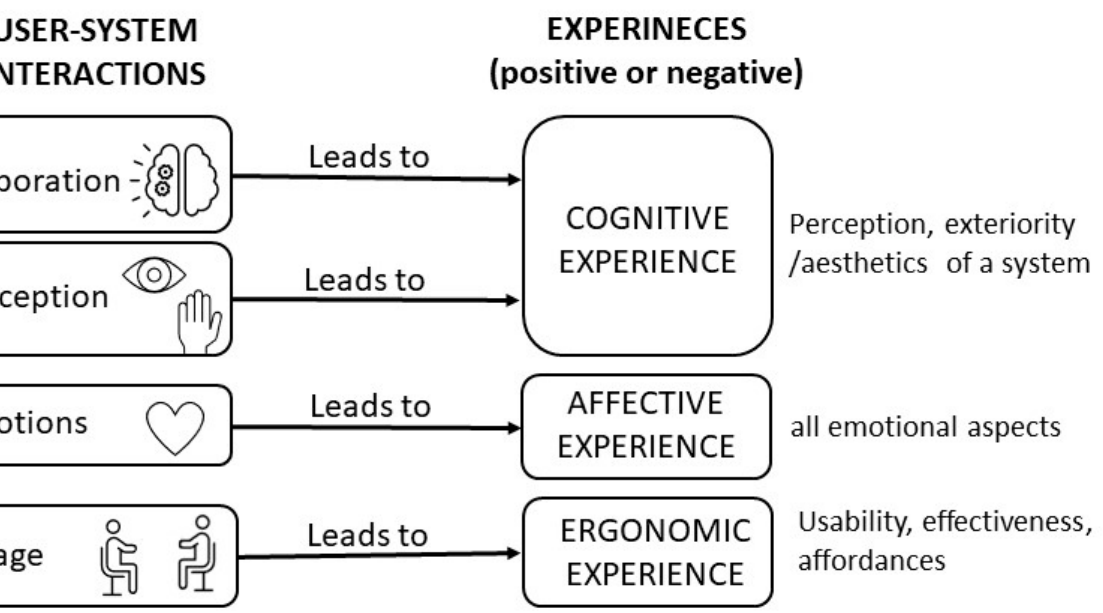
Figure 7. Representation of different experiences caused by different typologies of user-system interaction.